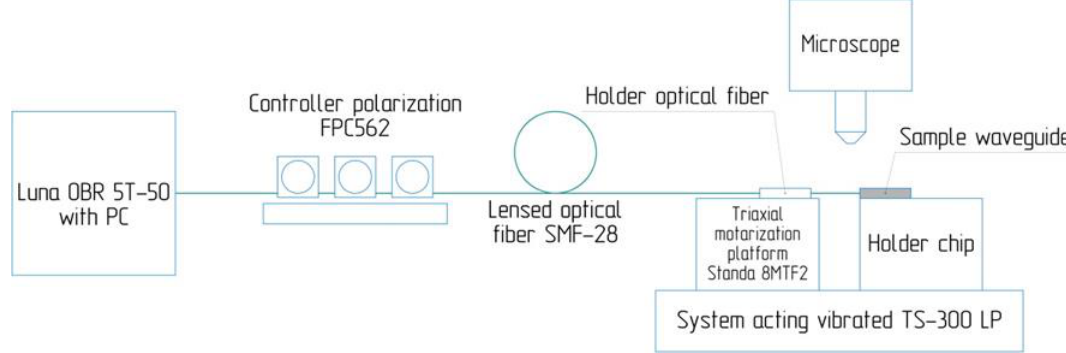
Figure 3. Scheme of studying optical losses in waveguides with widths of 3 and 8 microns.